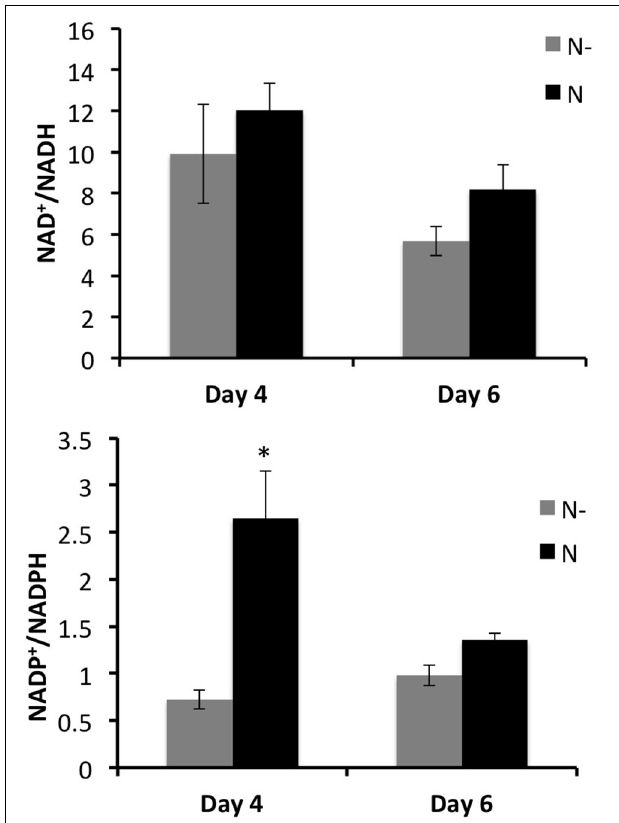
FIGURE 6 | Measured NAD + /NADH and NADP + /NADPH ratios in GT3 cell suspension, for two nitrogen conditions (N–, gray bars and N, black bars) at 4 and 6 days of culture. Values are means ± SE of 6 replicates (exp. 1 and exp. 2) and ∗ indicates significant difference according to Student’s t -test with p <